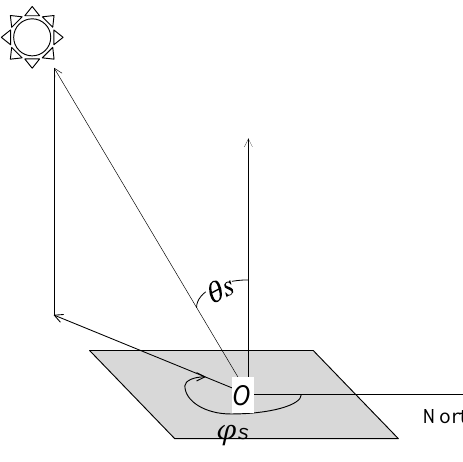
Figure 3. Sketch map of the solar zenith angle and azimuth angle in the horizontal plane. The solar zenith angle is measured from vertical, and the solar azimuth angle is measured clockwise from